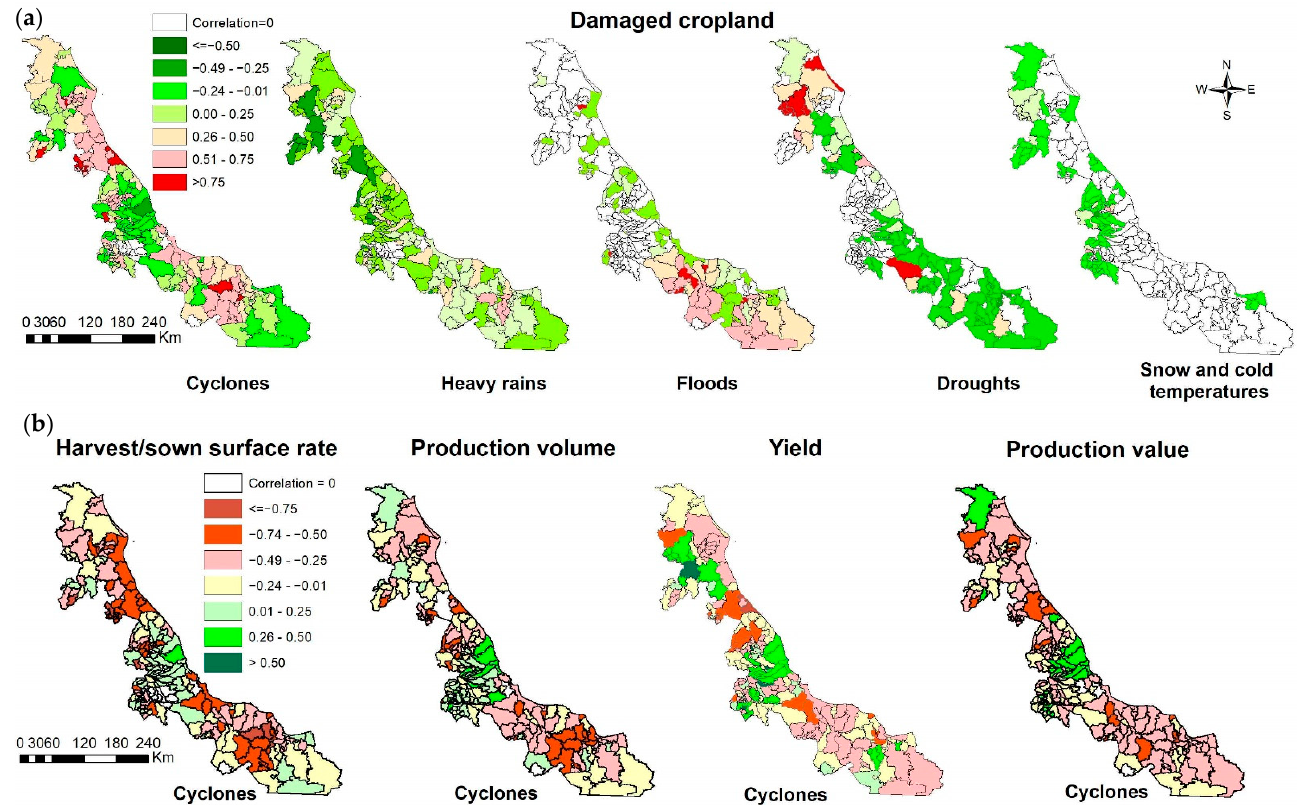
Figure 7. ( a ) Damaged corn land and production values correlated with disaster declarations in the municipalities of the State of Veracruz from 2003 to 2020. ( b ) Corn production data with the highest correlations with disaster declarations. No correlation: sites with no correlation with the phenomena. Source: projections based on data from the Mexican National Center to Prevent Disasters statistics [15] and the Mexican National Agrifood System [5].